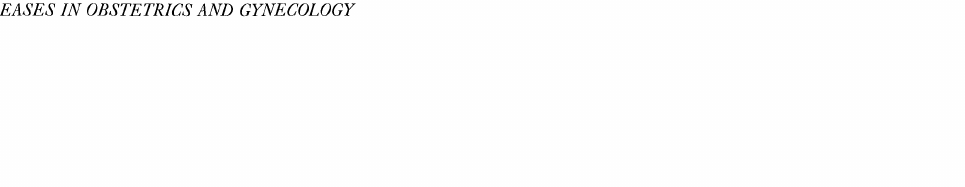
tics of the clinical and subclinical chorioamnionitis groups. There was no significant difference be- tween the two groups with respect to gestational age (P 0.056). There was a significant difference in two areas. The first was birth weight, with a mean weight of 1,365.89 g in the clinical group and 1,906.4 g in the subclinical group